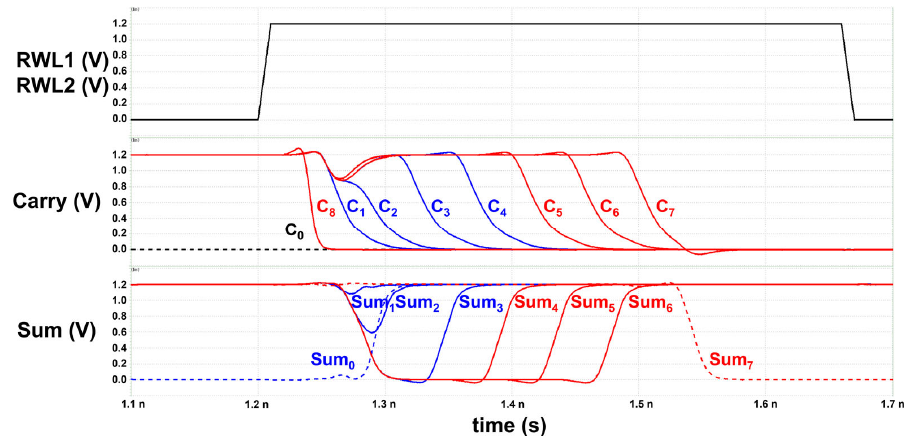
Figure 9. Timing graph of the proposed 8-bit IMC Ripple Carry Adder.